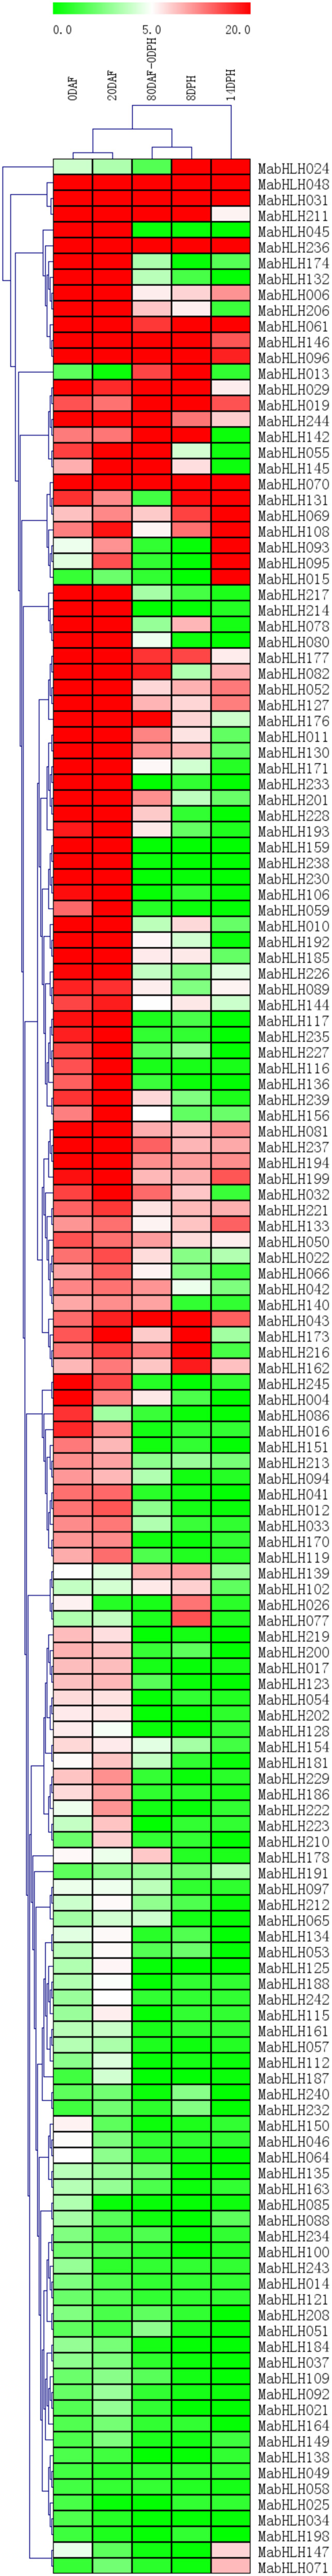
Expression patterns of MabHLHs in different stages of fruit development and ripening. The heatmap with dendrogram was created based on the RPKM value of the MabHLHs. Differences in gene expression changes are shown in color as the scale. Days after flowering (DAF) are fruit development stages, while days post-harvest (DPH) are fruit ripening stages.